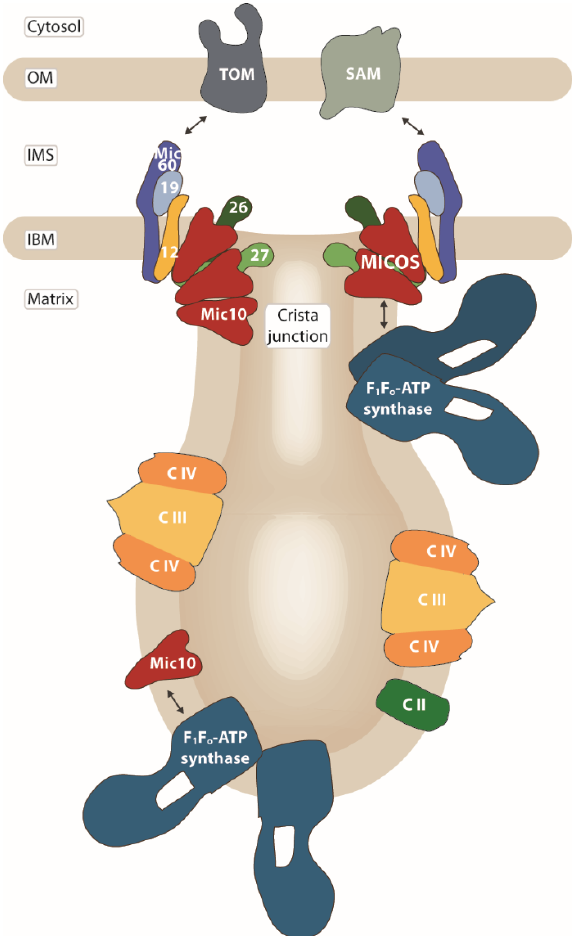
FIGURE 1: The mitochondrial contact site and cristae organizing system (MICOS) is required for the formation and stability of crista junctions of the inner mitochondrial membrane. Its core component Mic10 interacts with the F 1 F o -ATP synthase whose dimeric and oligomeric forms localize to strongly curved cristae tips and tubules. MICOS and the ATP synthase may associate via Mic10 at crista junctions (right), or a subpopulation of Mic10 may interact with the ATP synthase in cristae membranes (left). OM: outer membrane, IMS: intermembrane space, IBM: inner bounda- ry membrane, TOM: translocase of the outer membrane, SAM: sorting and assembly machinery, C II / III / IV: complexes II, III and IV of the respiratory